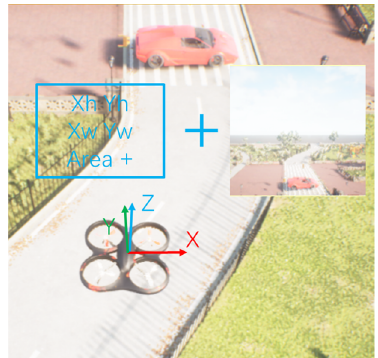
Figure 9. Observation and action space of the UAV. At each step, the UAV takes gray images and identifies information as observations and then performs actions accordingly.